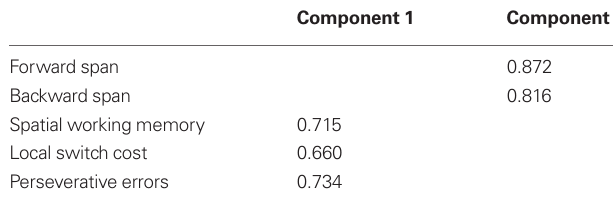
Table 6 | Principle component loadings of primary cognitive measures at baseline assessment; only component loadings > 0.40 are